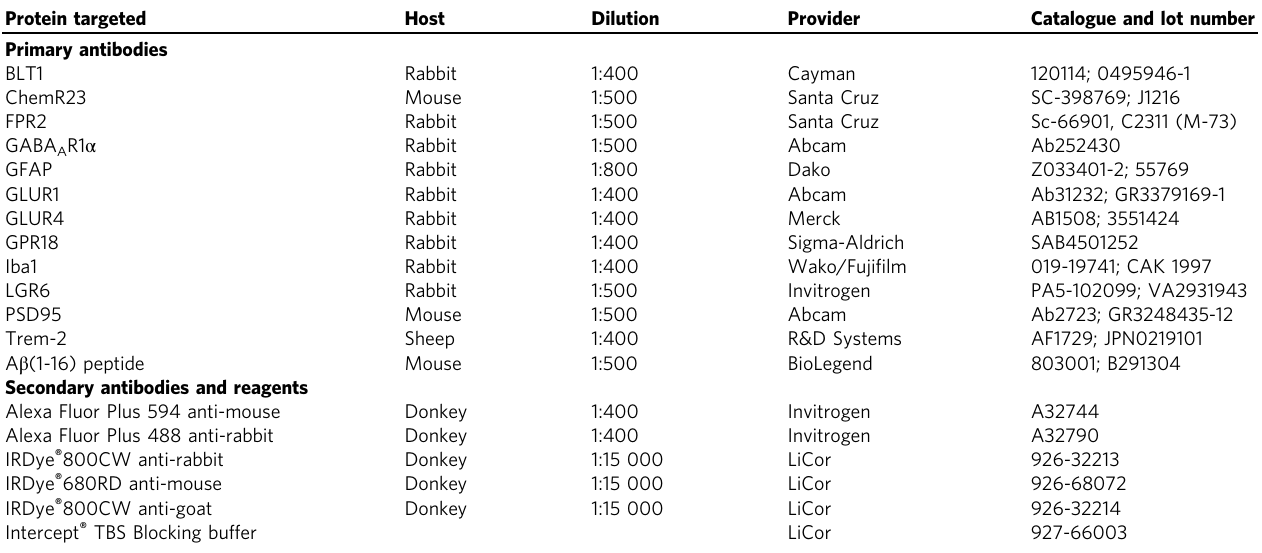
Table 1 Primary and secondary antibodies and reagents. Protein